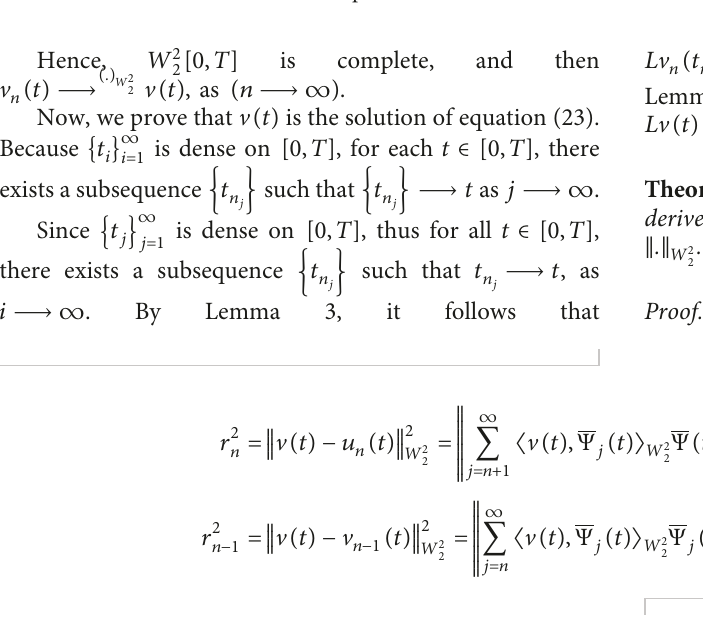
Figure 1: Graphs of numerical solution and absolute error with n � 22 for Example